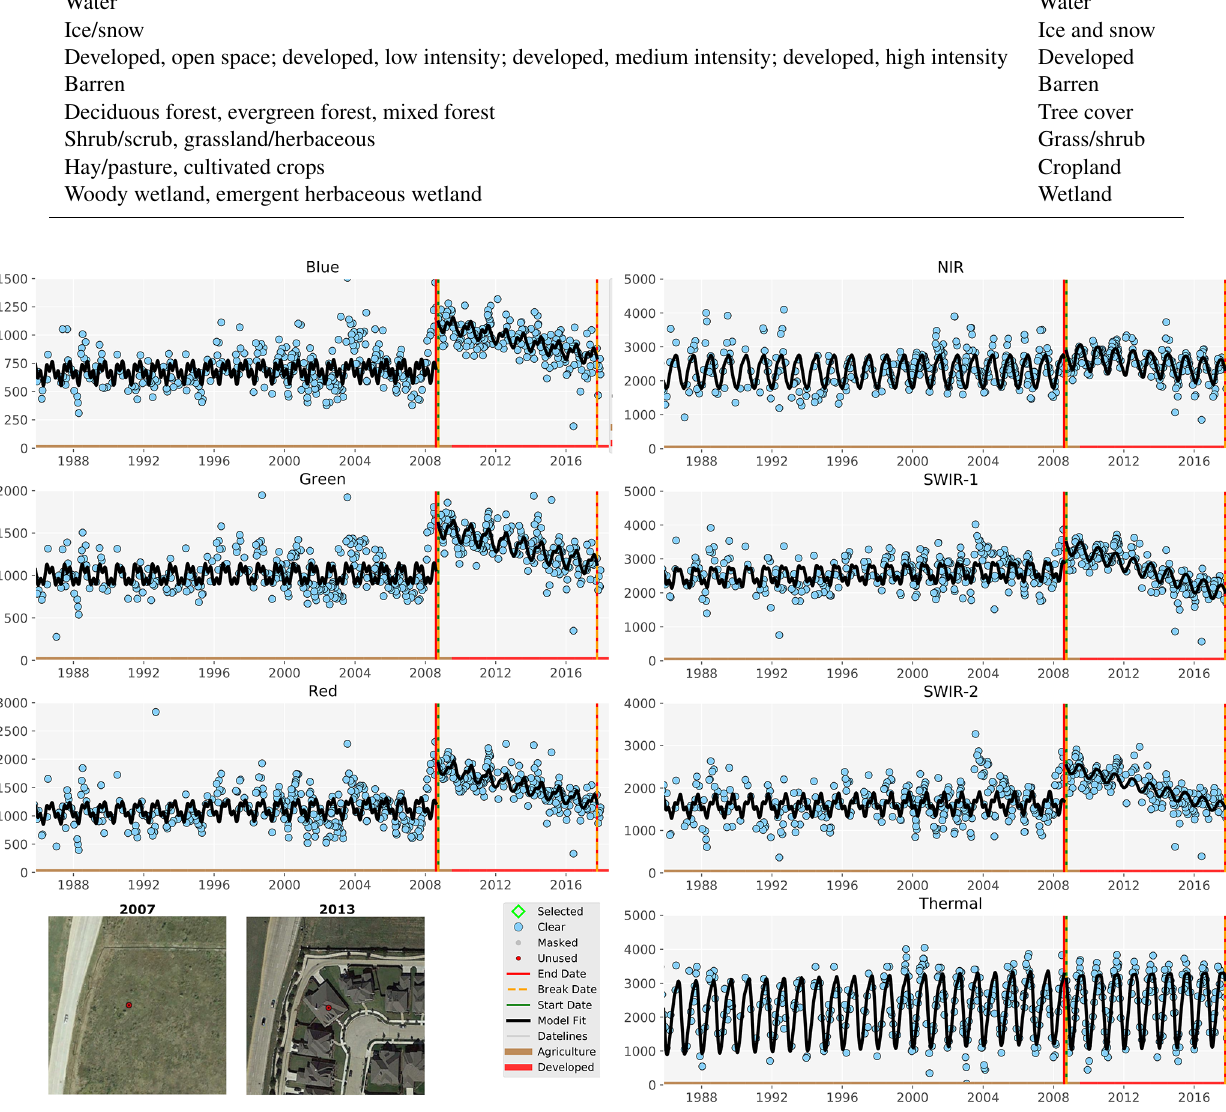
Figure 5. CCD change detection and segmentation using Landsat blue, green, red, near-infrared, shortwave infrared (SWIR) 1, shortwave infrared (SWIR) 2, and thermal bands. Blue dots are all available clear Landsat records in each year. The horizontal lines in different colors represent land cover classes labeled by the algorithm. The vertical lines show model break dates. The black line is the model fits. The high-resolution images show landscape conditions in 2007 and